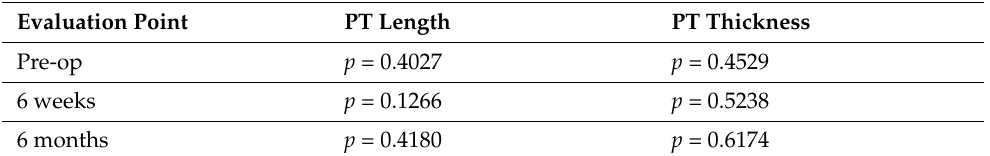
Figure 3. PT length and thickness in both groups of patients preoperatively and at both postoperative examinations. Asterisks denote significant differences between values. Table 4. Comparison of PT length and PT thickness between groups A and B; p values of Mann– Whitney U test are presented.